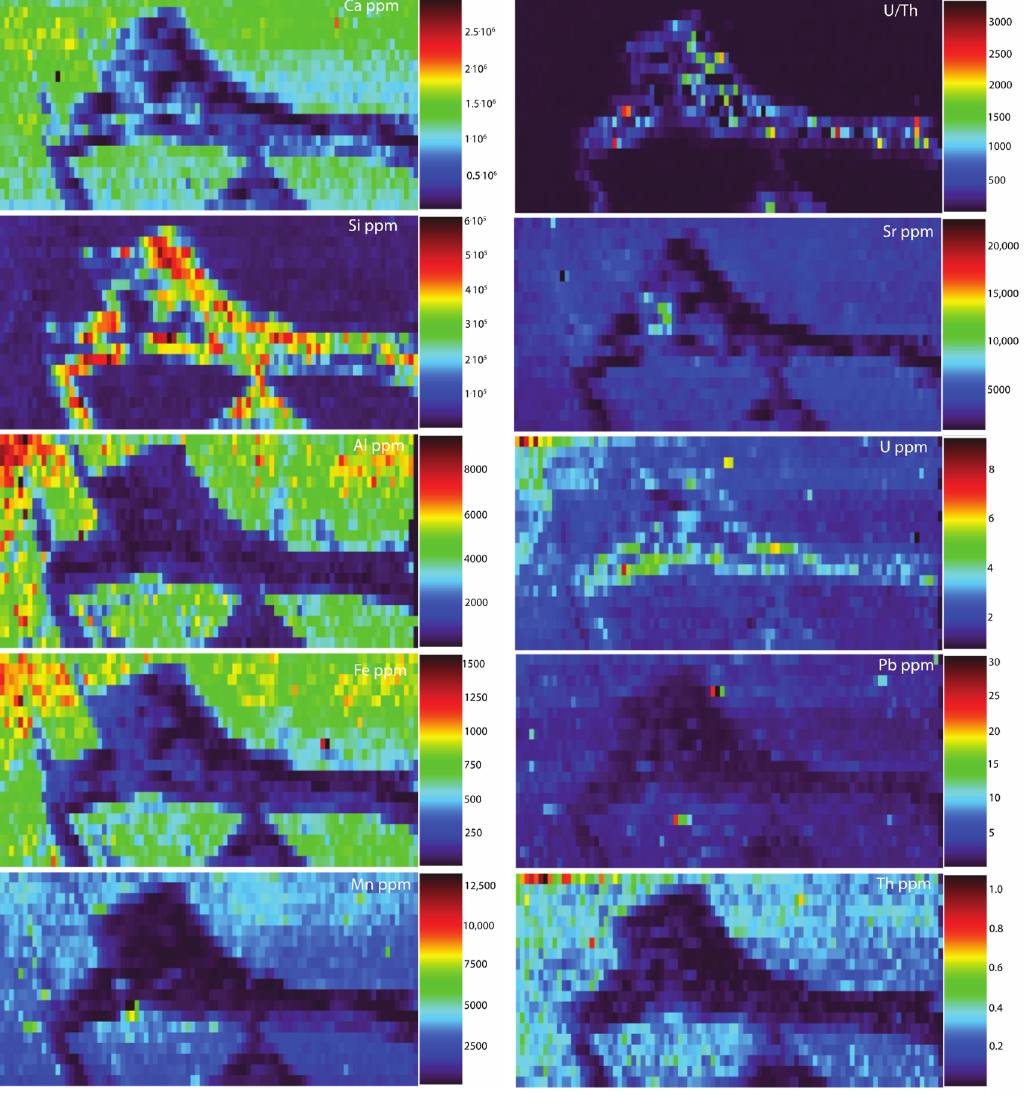
Figure 5. Element distributions in the studied sample via LA. Laser ablation maps of nine elements in the studied sample.